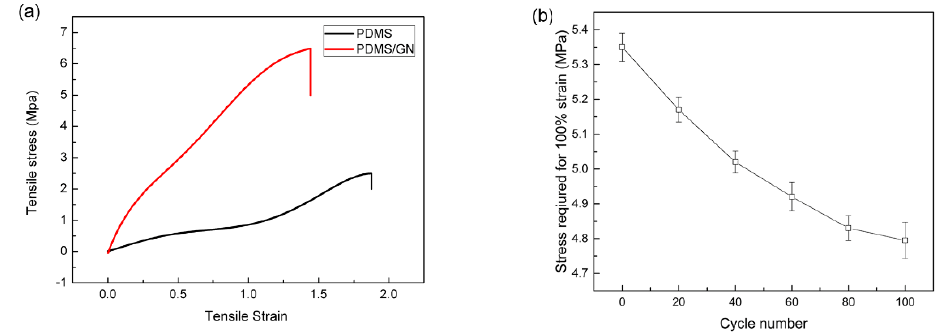
Figure 6. ( a ) Tensile strain-stress curves of PDMS and PDMS / GN; ( b ) stress required for 100% strain for 0–100 stretching and release cycles.